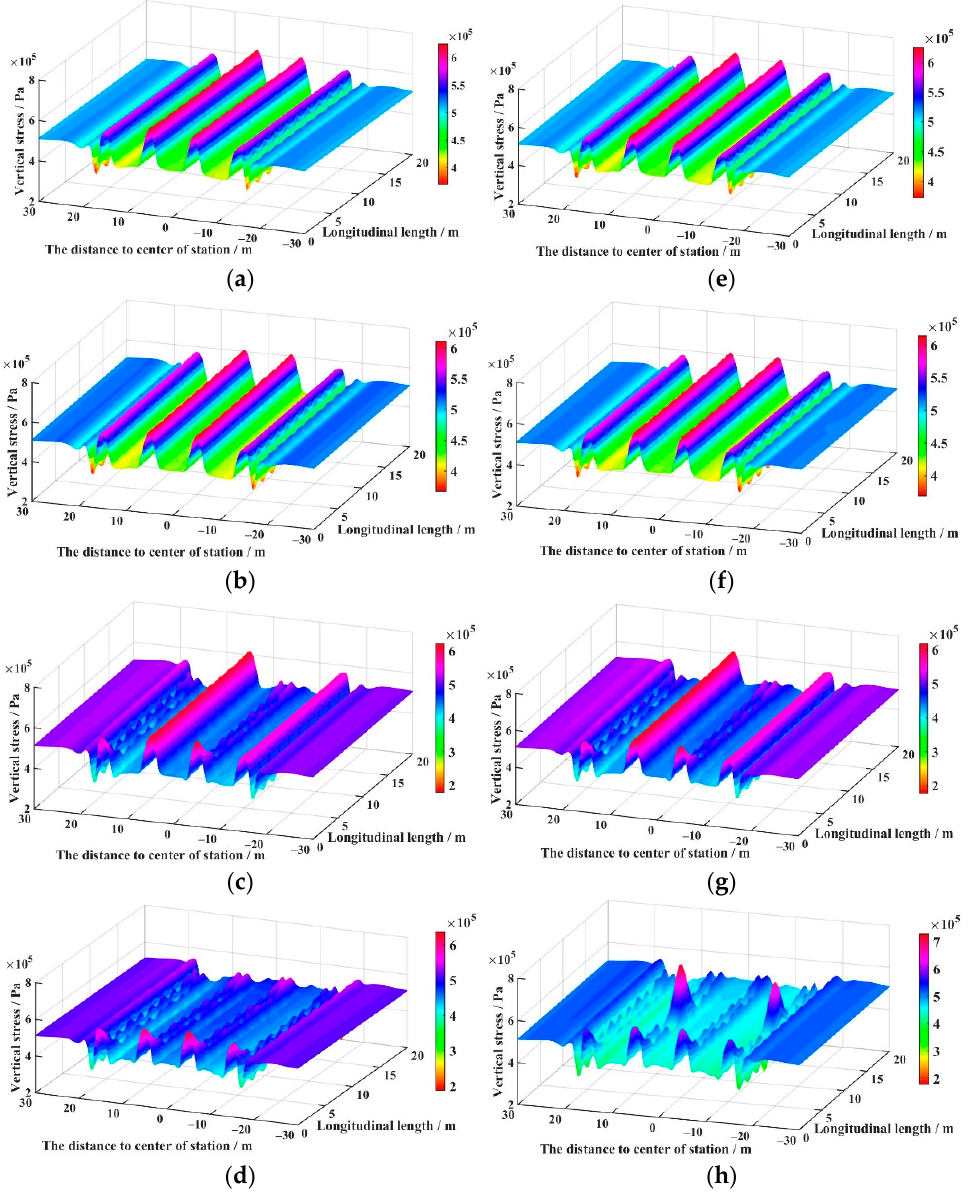
Figure 10. Formation processes of the stress fields in schemes 3 and 6: ( a ) 1-3, ( b ) 1-3-2-4, ( c )